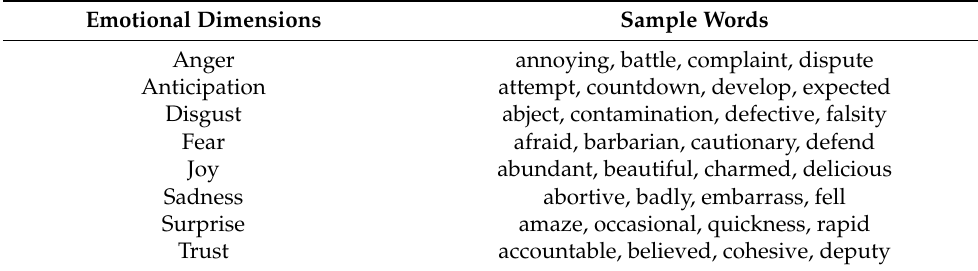
Table 1. Sample words of Plutchik’s